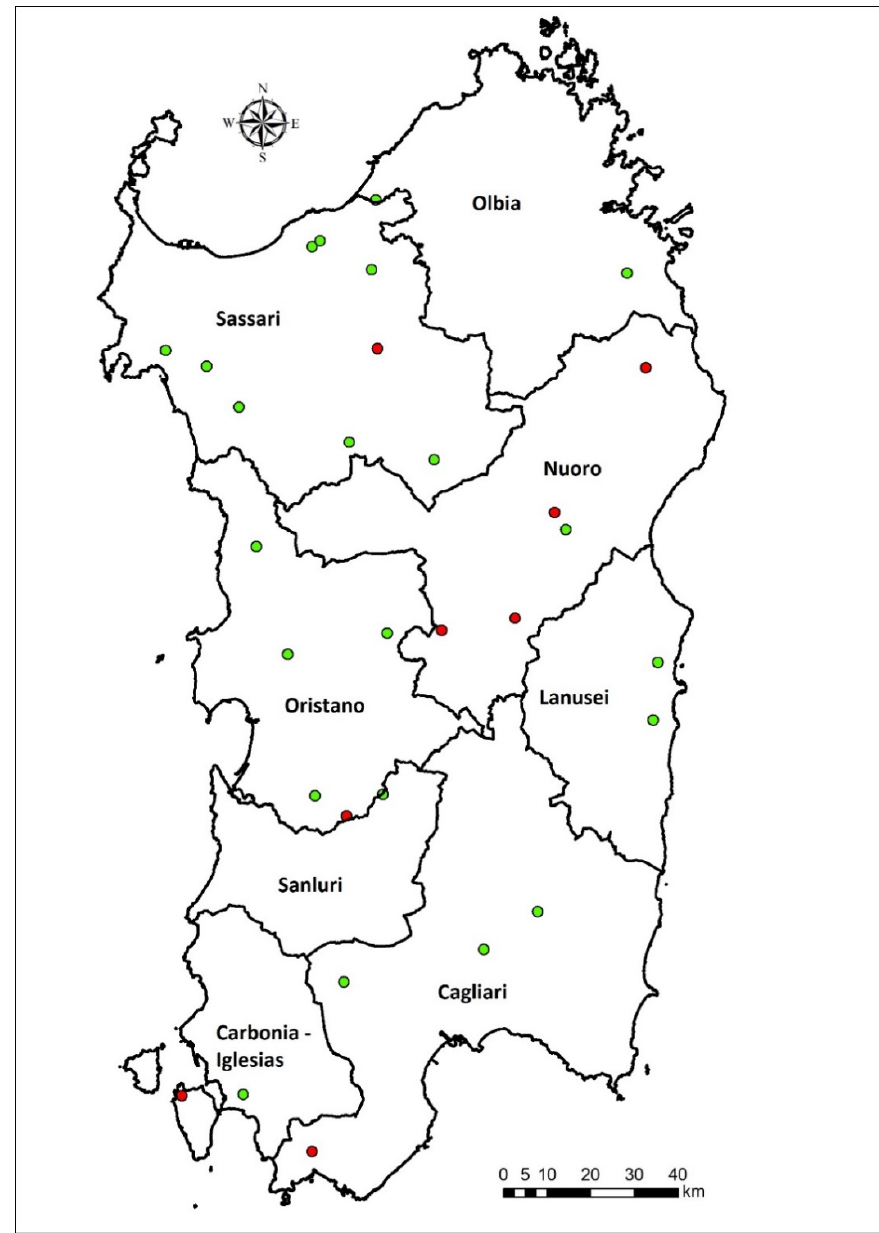
Figure 1. Map of the educational farms sampled. Positive samples are represented by red points, while negative samples are highlighted with green points. ASL limits are represented by black lines. Table 4. Samples collected from the 30 educational farms involved in this Table 3. Analysis of territorial context for each ASL: sheep farms per Km 2 , sheep per Km 2 , total number of sheep. Data are presented as number (percentage, %) or mean and standard deviation (SD), calculated by municipalities included in each ASL.